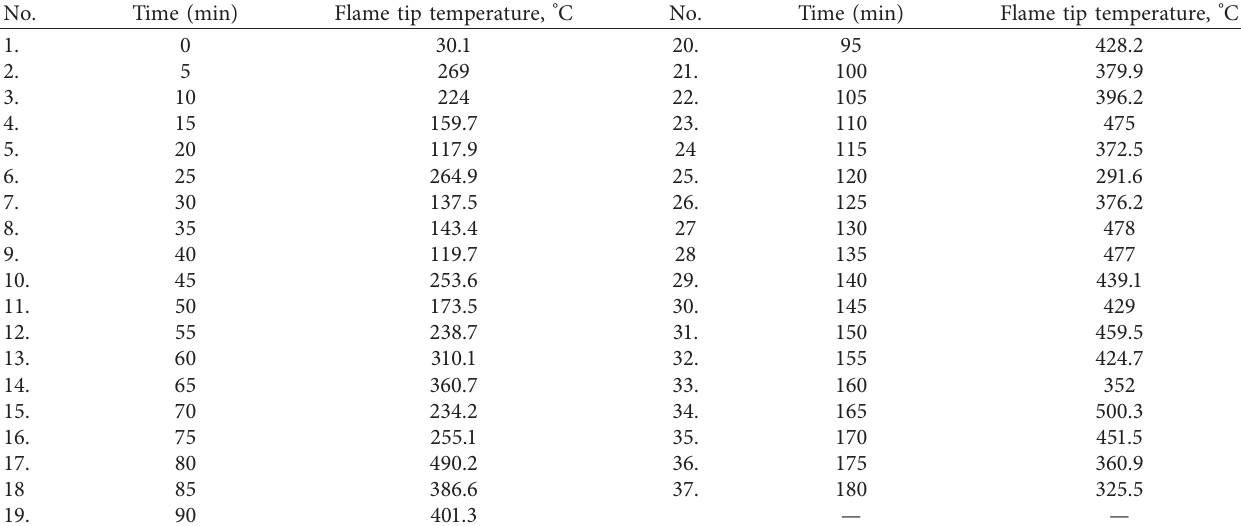
Table 3: Time-dependent flame tip temperature.